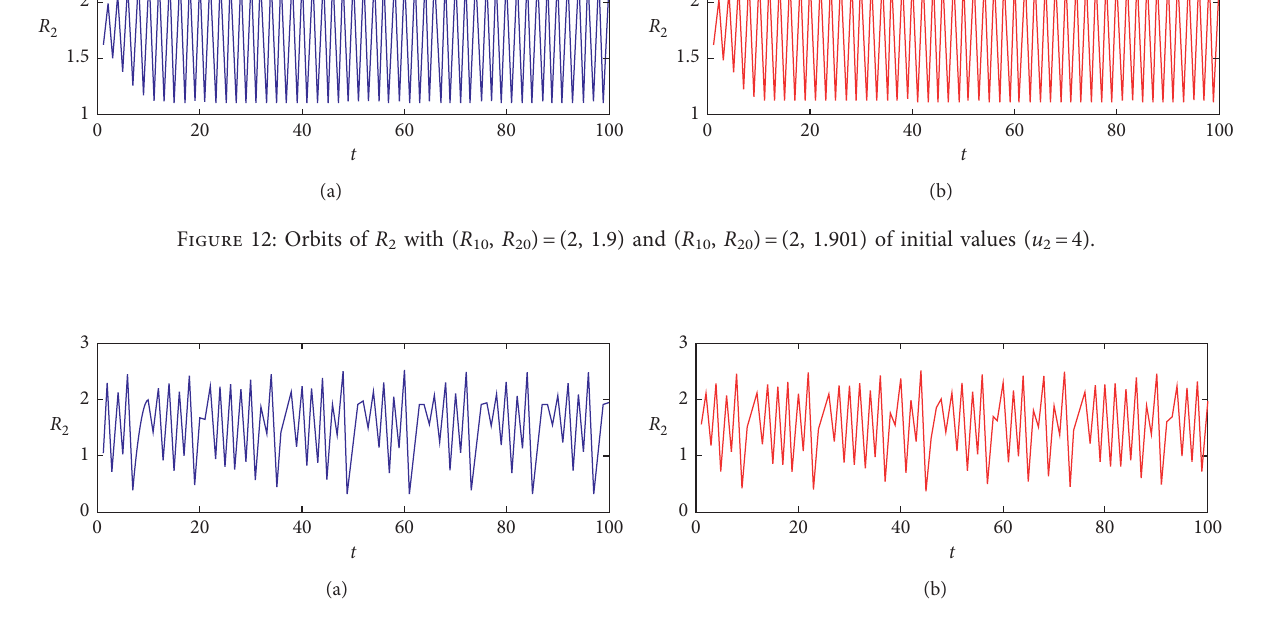
� (2, 1.901) of initial values ( u 10 , R 20 )